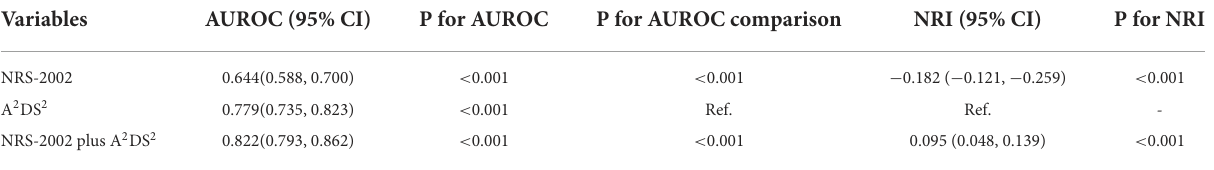
TABLE 3 Predictive value of the NRS-2002, NIHSS and A 2 DS 2 for stroke-associated infection.